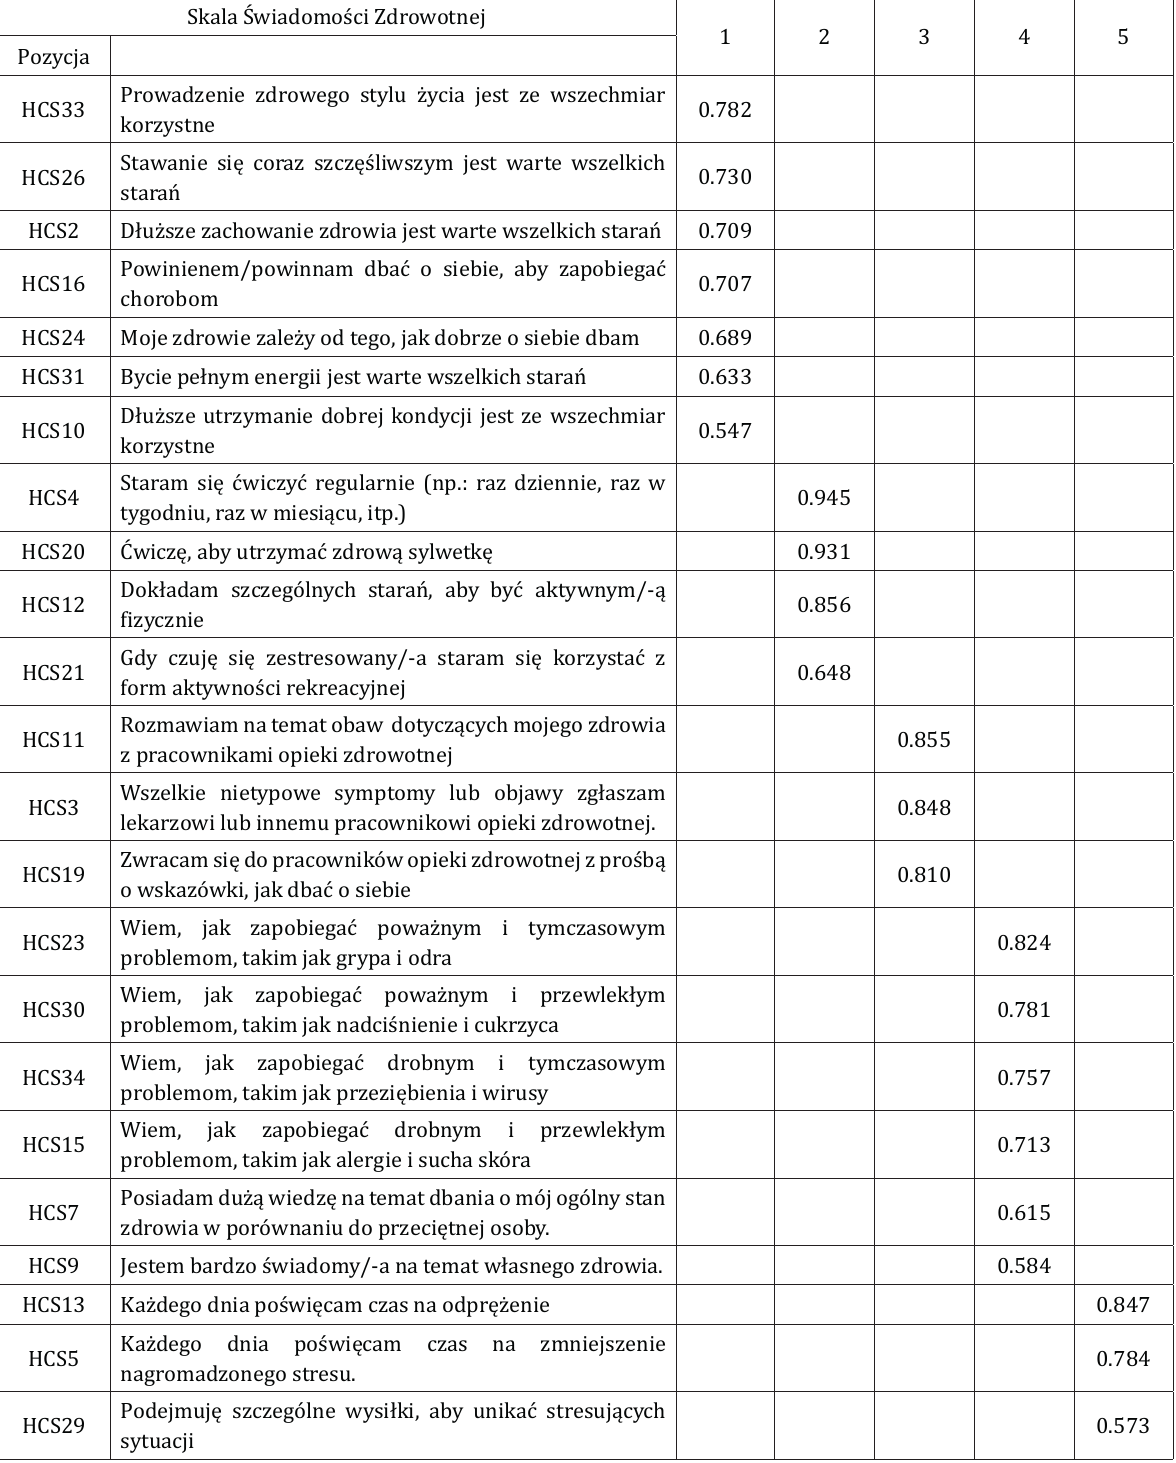
Tabela 2. Ładunki czynnikowe poszczególnych pozycji w ramach 5-czynnikowej struktury